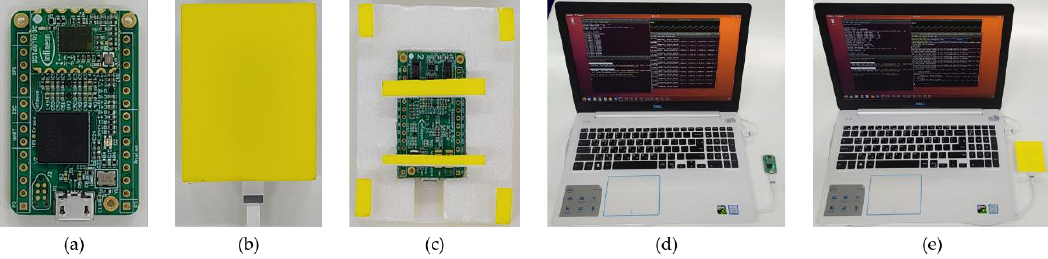
Figure 13. Hardware for the hand gesture recognition system. ( a ) 60 GHz FMCW radar module; ( b ) radar module with case (front); ( c ) radar module with case (back); ( d ) radar–laptop connection without case; ( e ) radar-laptop connection with case.